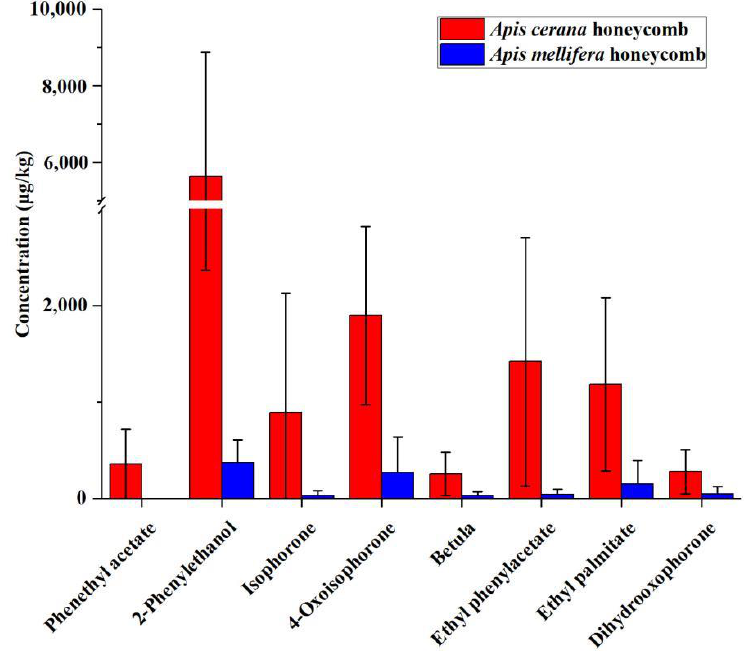
Figure 4. Quantitative results of the potential markers in ACC. Table 3. Potential markers in ACC identified by GC−MS.